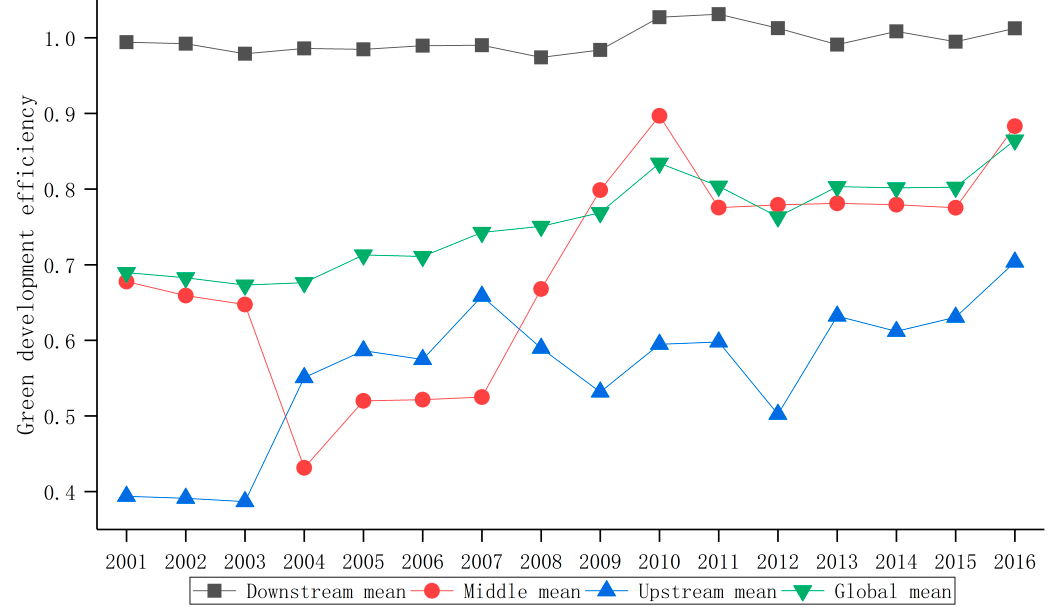
Figure 2. Evolution trend of green development efficiency of the paper industry in Yangtze River Economic Belt.